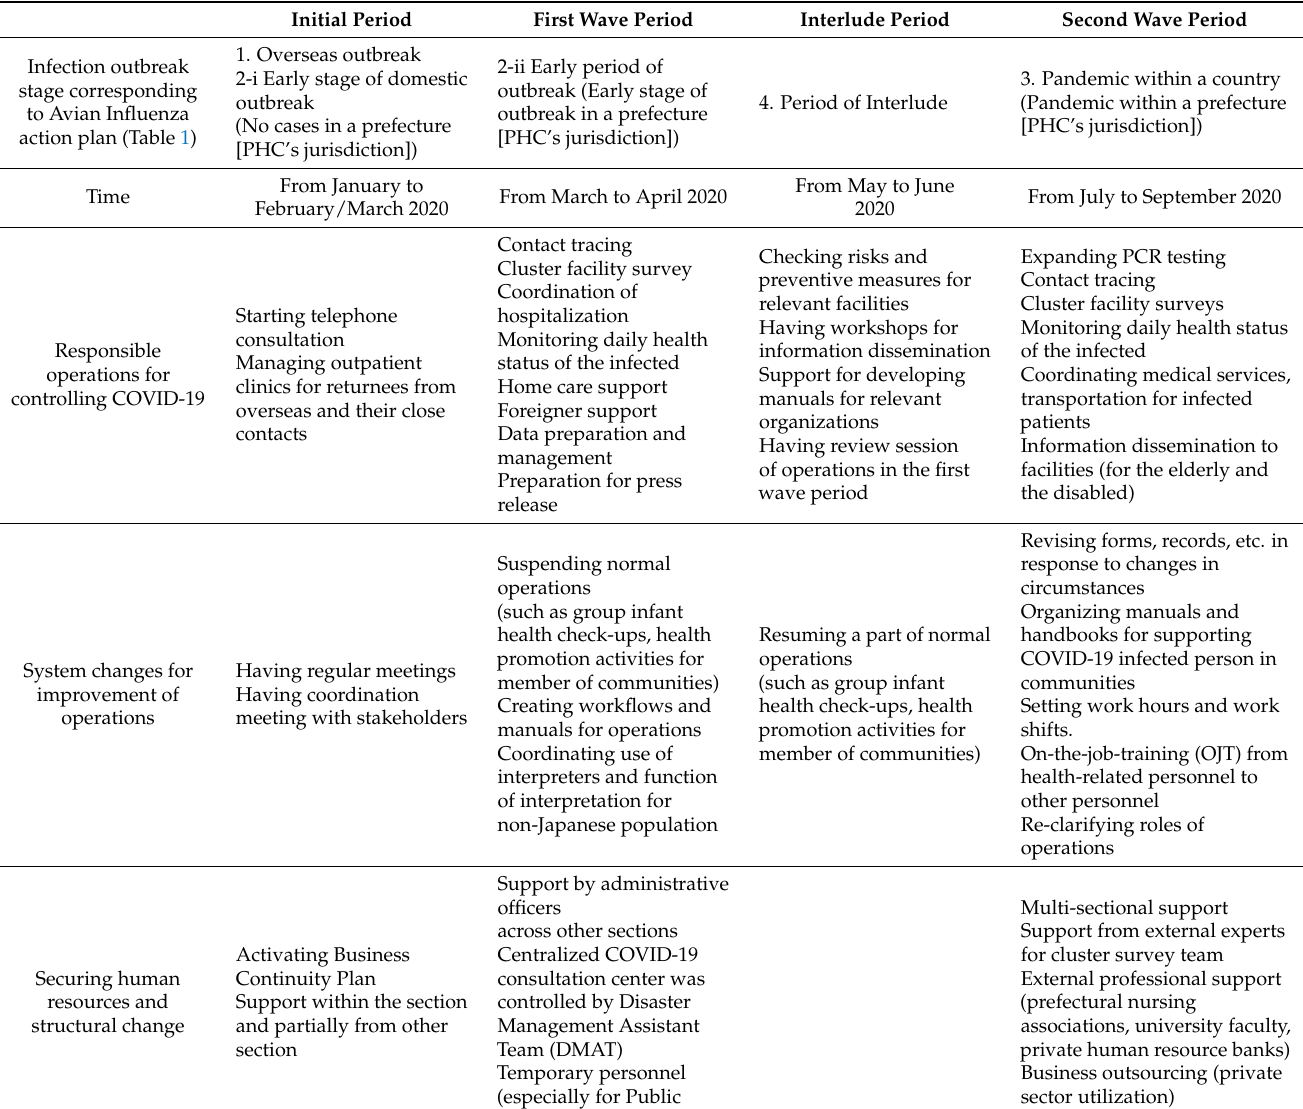
Table 2. Responsible operations for controlling COVID-19 and supportive environment for